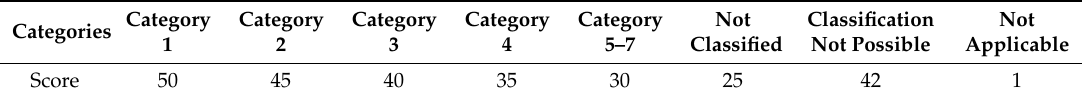
Table 4. Results of quantifying health hazard